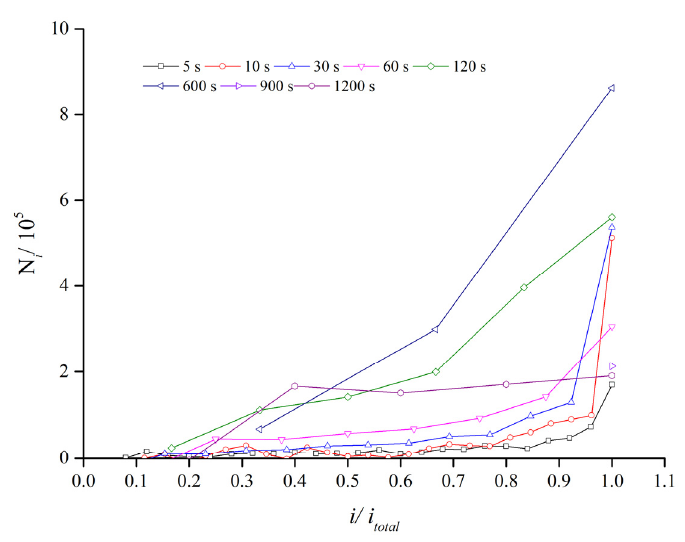
where N 2 i +1 is the total number of AE counts produced by the odd-numbered circles ( β circles), N 2 i is the total number of AE counts produced by the even-numbered circles ( α circles), i is the ordinal, and X is the fatigue interval (in seconds). Figure 12 shows the effect of the fatigue interval on the computed values of N i (X).